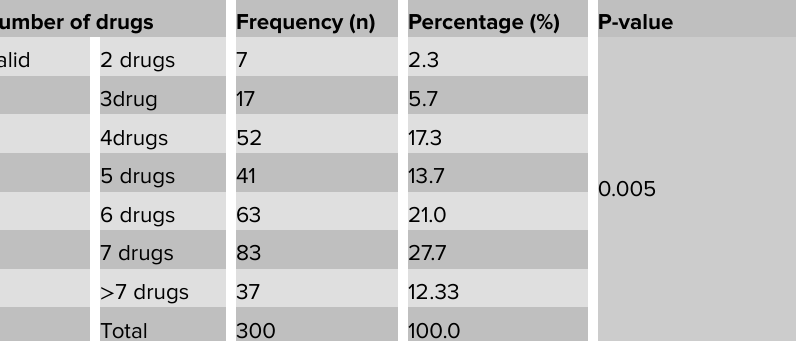
TABLE 3: Drugs prescribed per prescription.